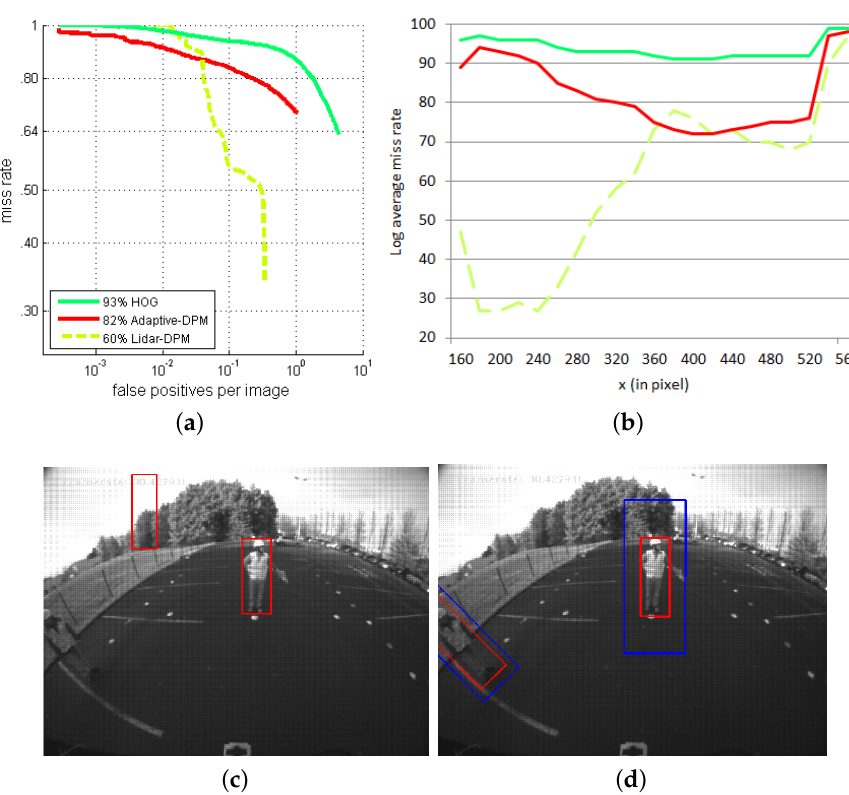
Figure 18. Comparison of detection performance between the exclusively vision-based approaches and the LiDAR-fisheye camera PDS in Configuration 2: ( a ) ROC curve, ( b ) Miss rate for lateral image position, ( c ) vision-only detections and ( d ) LiDAR-fisheye